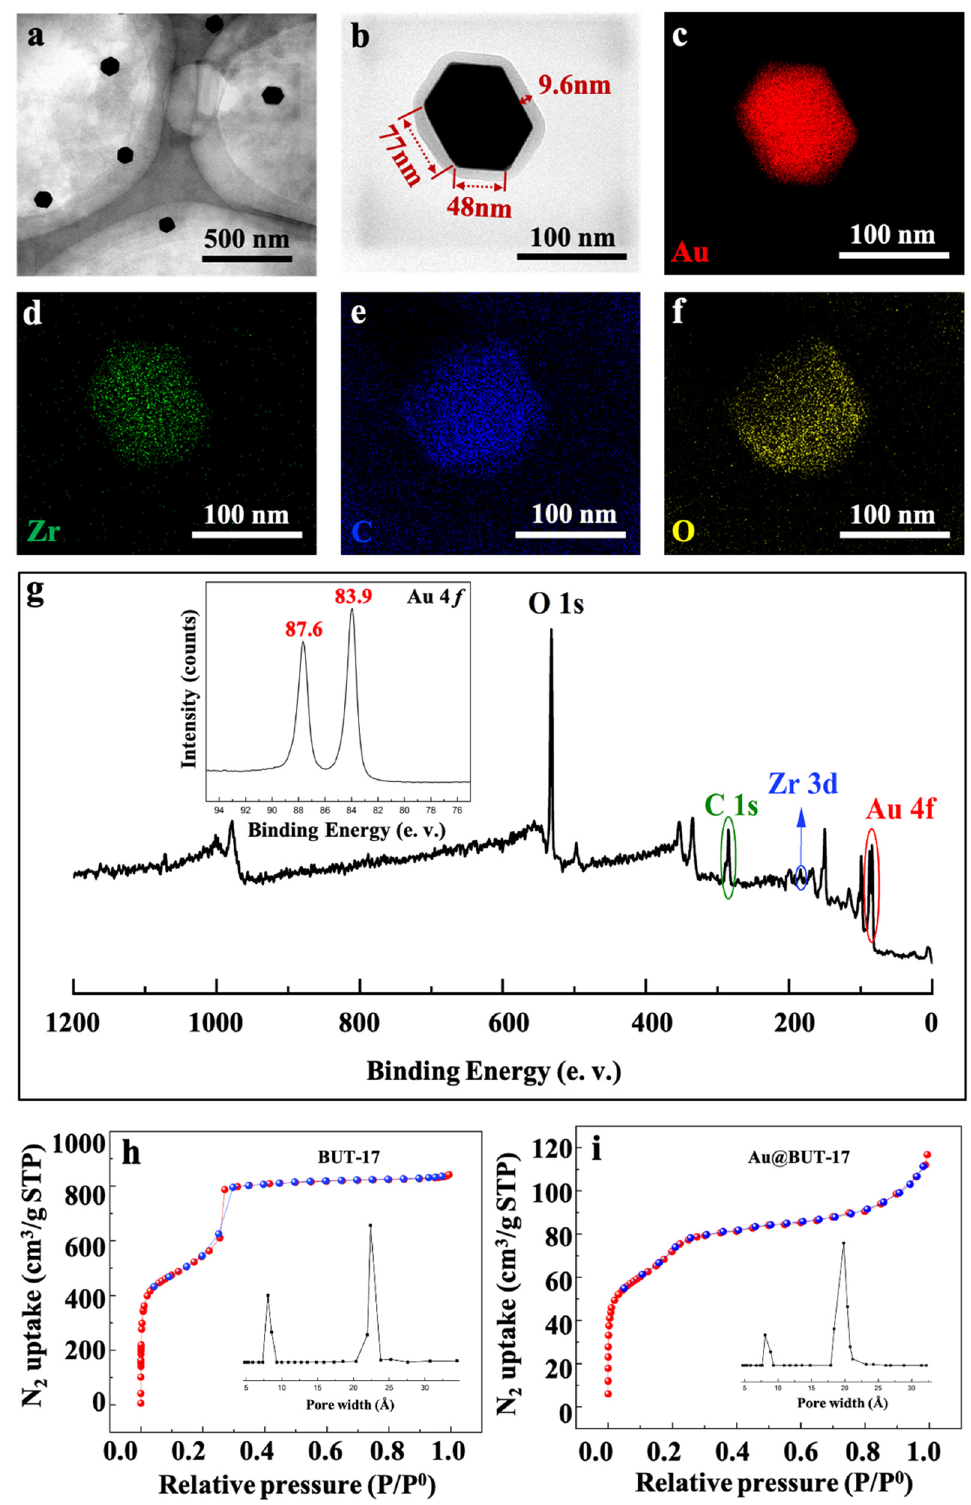
Figure 1. ( a ) TEM image of Au@BUT-17 NPs synthesized; ( b ) representative TEM image of single Au NP with diameter 48 nm × 77 nm encapsulated in BUT-17 shell with the thickness of 9.6 nm; ( c – f ) EDX elemental mapping of the element Au, Zr, C, and O shown in ( b ); ( g ) XPS spectrum of Au@BUT-17 NPs and the enlarged Au 4f region (insert); ( h , i ) N 2 adsorption/desorption isotherms of BUT-17 and Au@BUT-17 at 77 K. The inset shows DFT pore size distribution evaluated by using the N 2 adsorption data.